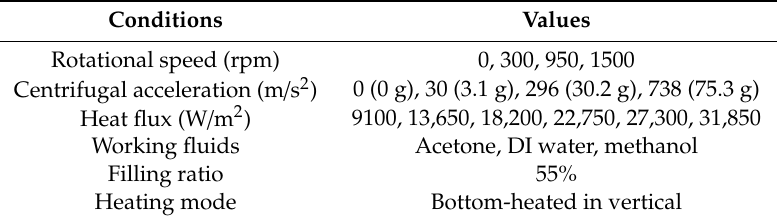
Table 1. Experimental conditions.